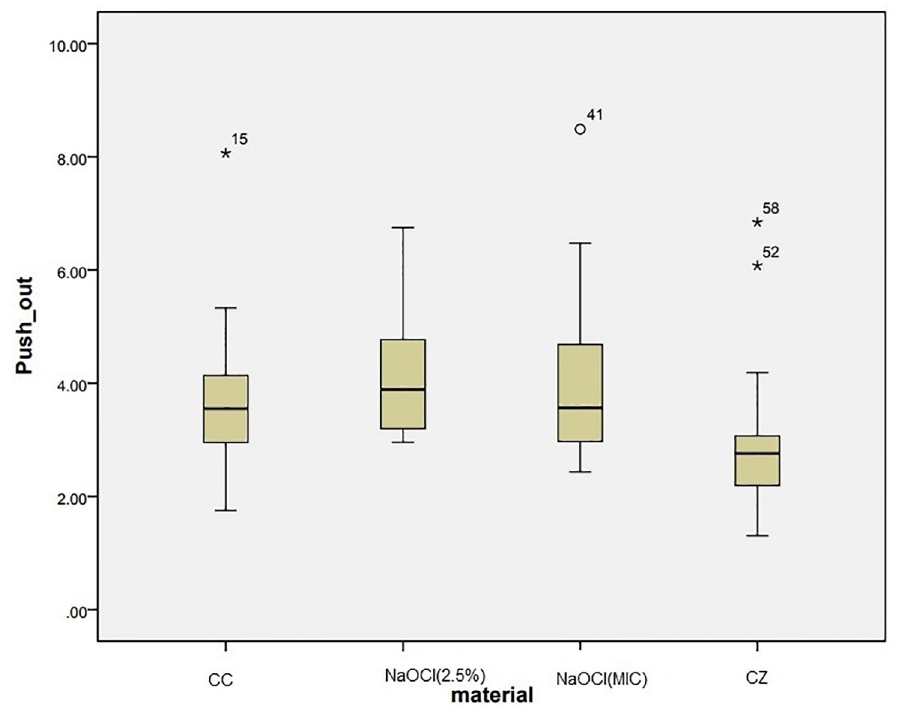
Fig 4. Push out bond strength of experimental